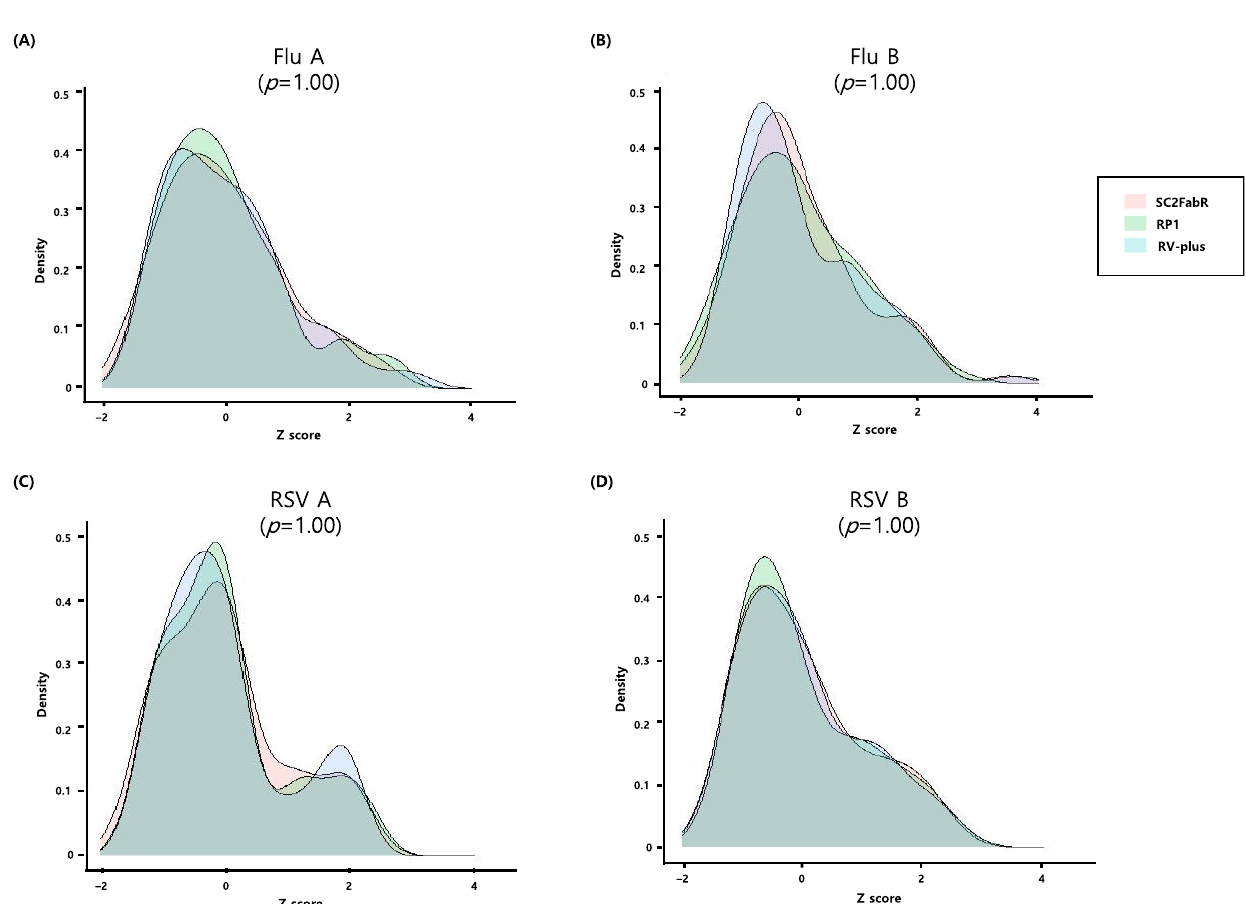
Figure 4. Densities of transformed Ct values obtained from SARS-CoV-2 data following within-assay normalization. Solid lines correspond to the SC2FabR, RP1, and RV-plus assays Flu A, influenza virus type A ( A ); Flu B, influenza virus type B ( B ); RSV A, respiratory syncytial virus A ( C ); RSV B, respiratory syncytial virus B ( D ).